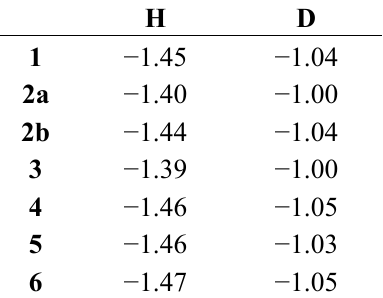
Table 4. Difference between the GIAO-calculated nuclear magnetic shielding (ppm) obtained with the MC_B3LYP and B3LYP//MC_B3LYP methods on hydrogen atom in 1 – 6